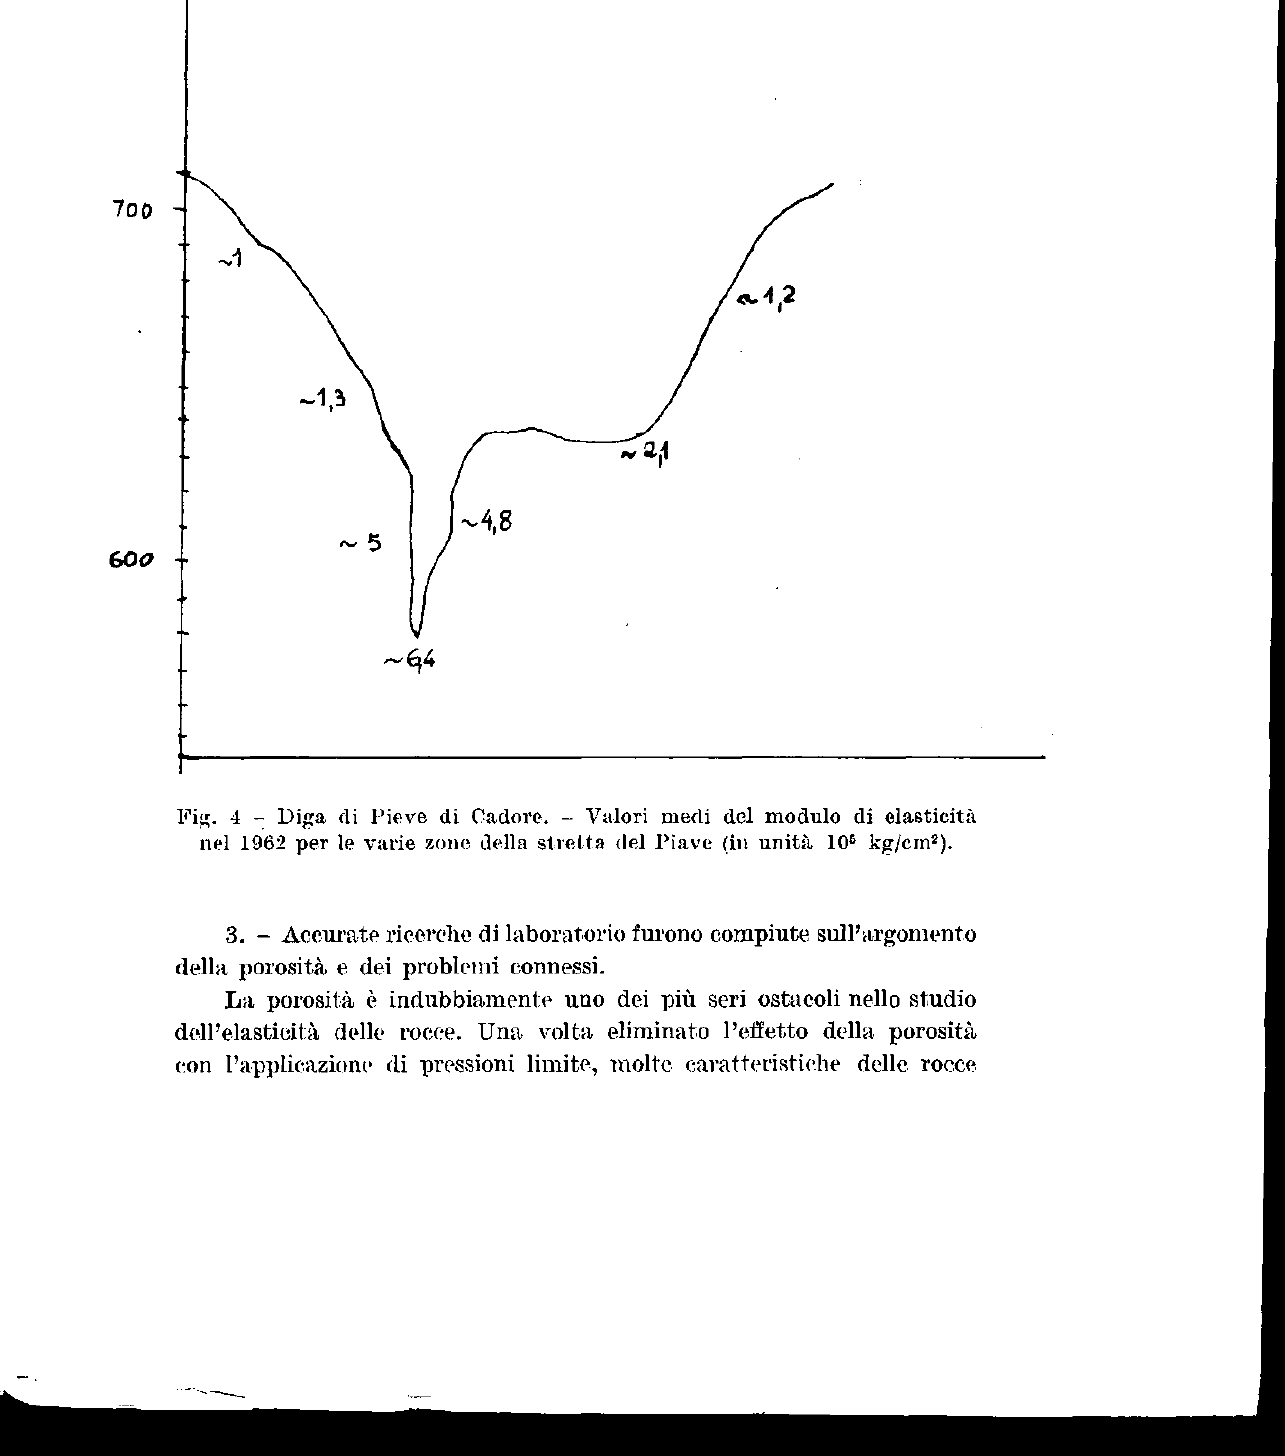
Fig. 4 - Diga di Pieve di Cadore. - Valori medi del modulo di elasticità nel 1962 per le varie zone della stretta del Piave (in unità IO 6 kg/cm 2 ).